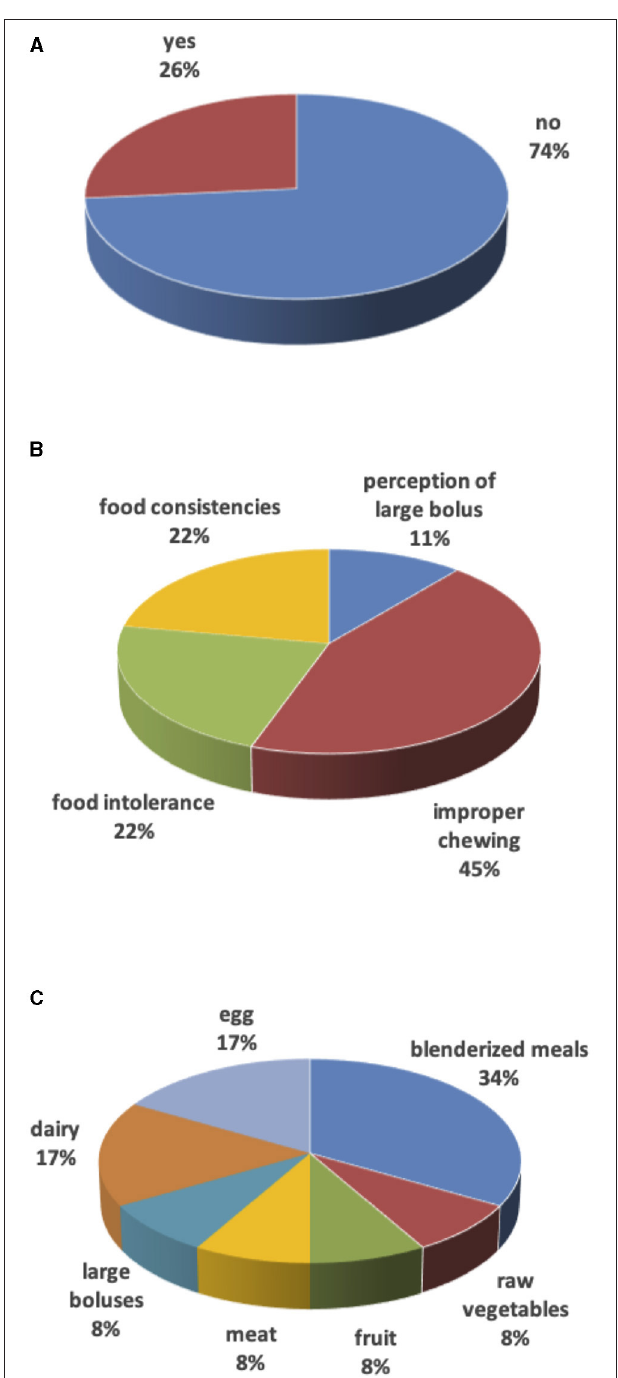
FIGURE 2 | Weaning. (A) Weaning delay. (B) Reasons for weaning delay. (C) Food causing weaning delay. Families were also asked if they had received any nutrition counseling after weaning. The majority (53%) responded negatively, while the remaining 47% seemed to have different sources of counseling such as pediatricians and other